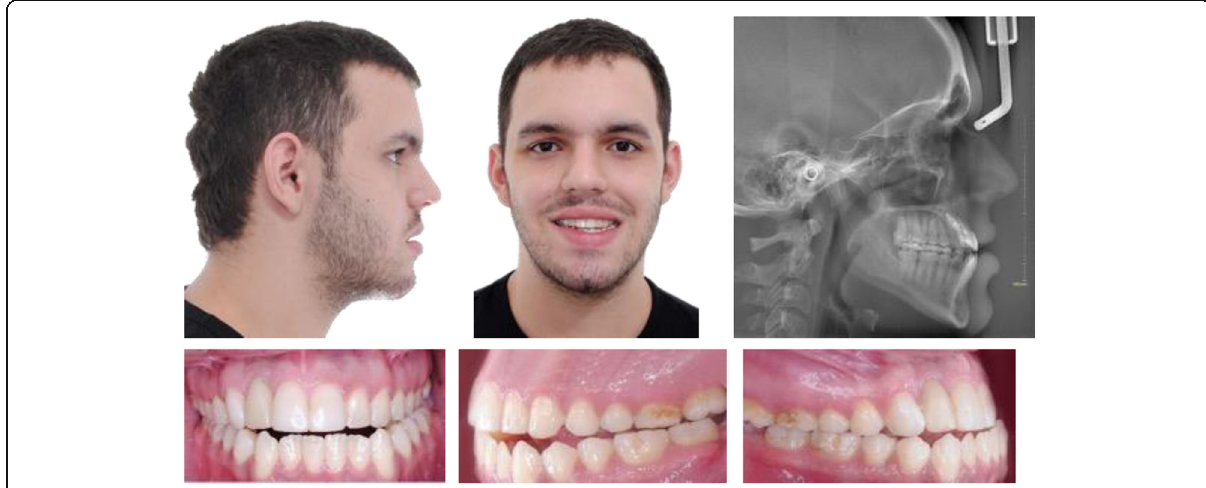
Fig. 1 Pre-treatment extra-oral and intra-oral photos, and lateral cephalic